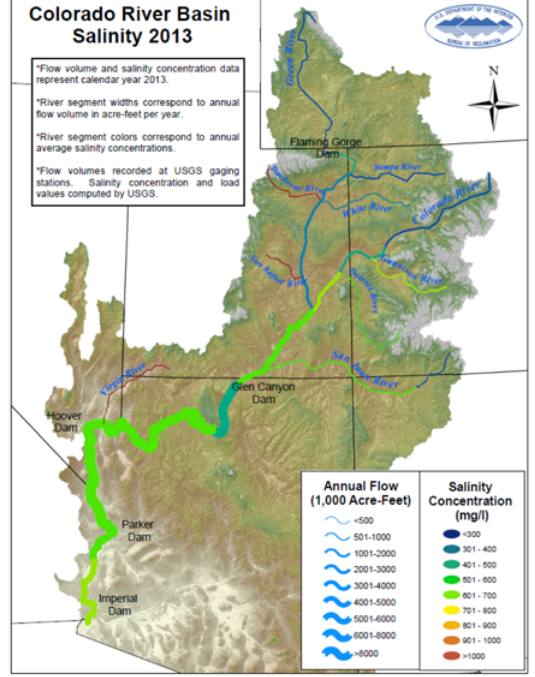
Figure 3. Colorado River Basin Salinity, 2013 [47]. Reproduced with permission from the U.S. Bureau of Reclamation (U.S. BOR).